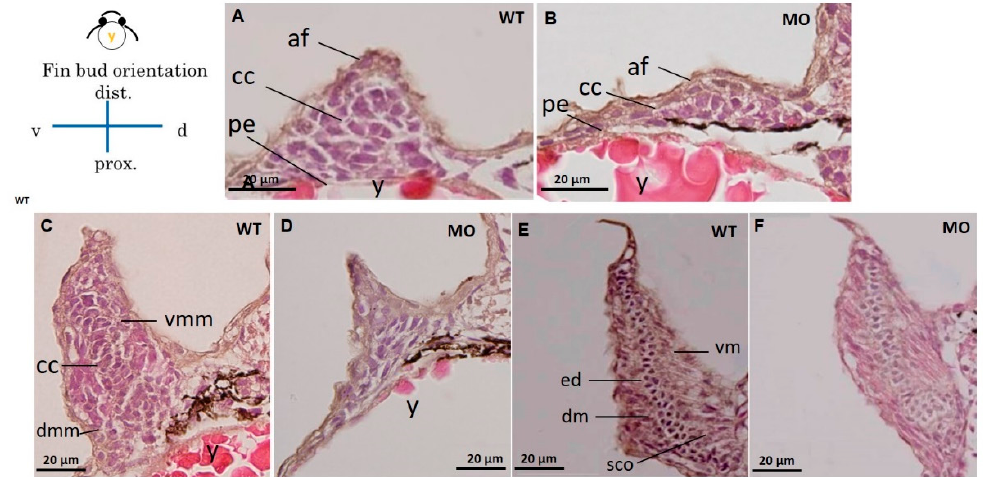
Figure 3. Cross section of a pectoral fin stained with HE. Wild-type embryos with well-developed myocytes and organized chondrocytes in pectoral fins at 37 ( A ), 48 ( C ), and 72 hpf ( E ). The hypoplastic pectoral fin of the tbx5a morphant showed reduced myocytes and disorganized chondrocytes at 37 ( B ), 48 ( D ) and 72 hpf ( F ). (af, apical fold; cc, chondrogenic condensation; dm, dorsal musculature; dmm, dorsal myogenic mesenchyme; ed. endoskeleton disc; vm, ventral musculature; vmm, ventral myogenic mesenchyme; pe, peritoneal epithelium; y, yolk, WT, Uninjected group, MO, tbx5 morphant group).